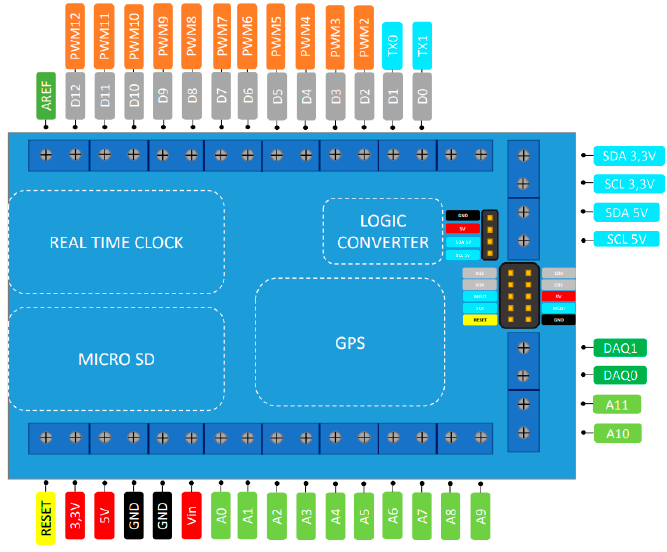
Figure 1. Low-cost data acquisition (LC-DAQ) shield pinout.